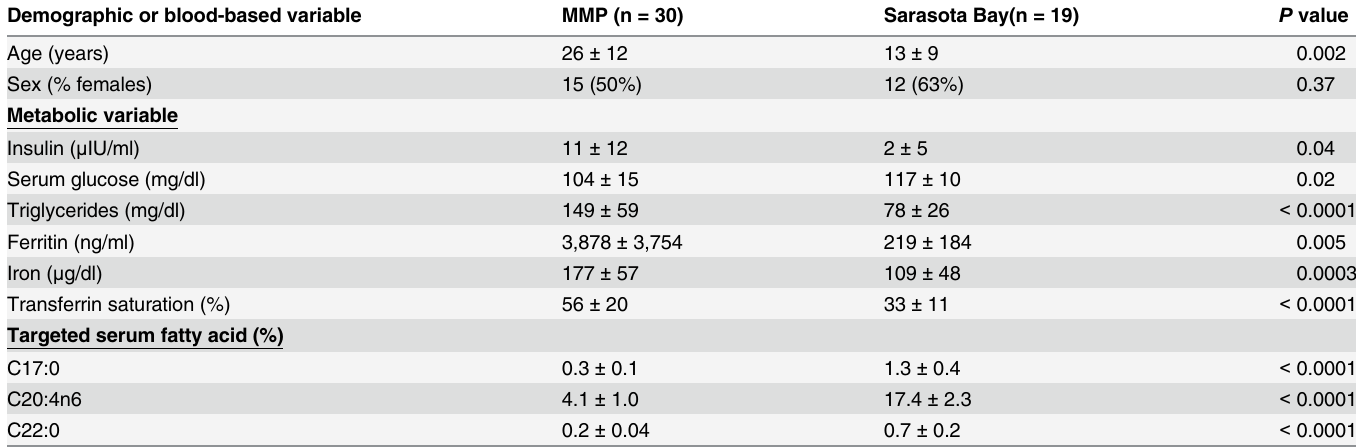
Table 1. Comparisons of demographics, metabolic health indicators, and targeted serum fatty acids between Navy Marine Mammal Program and Sarasota Bay, Florida bottlenose dolphins. Comparisons of metabolic variables and targeted serum fatty acids controlled for age. Demographic or blood-based